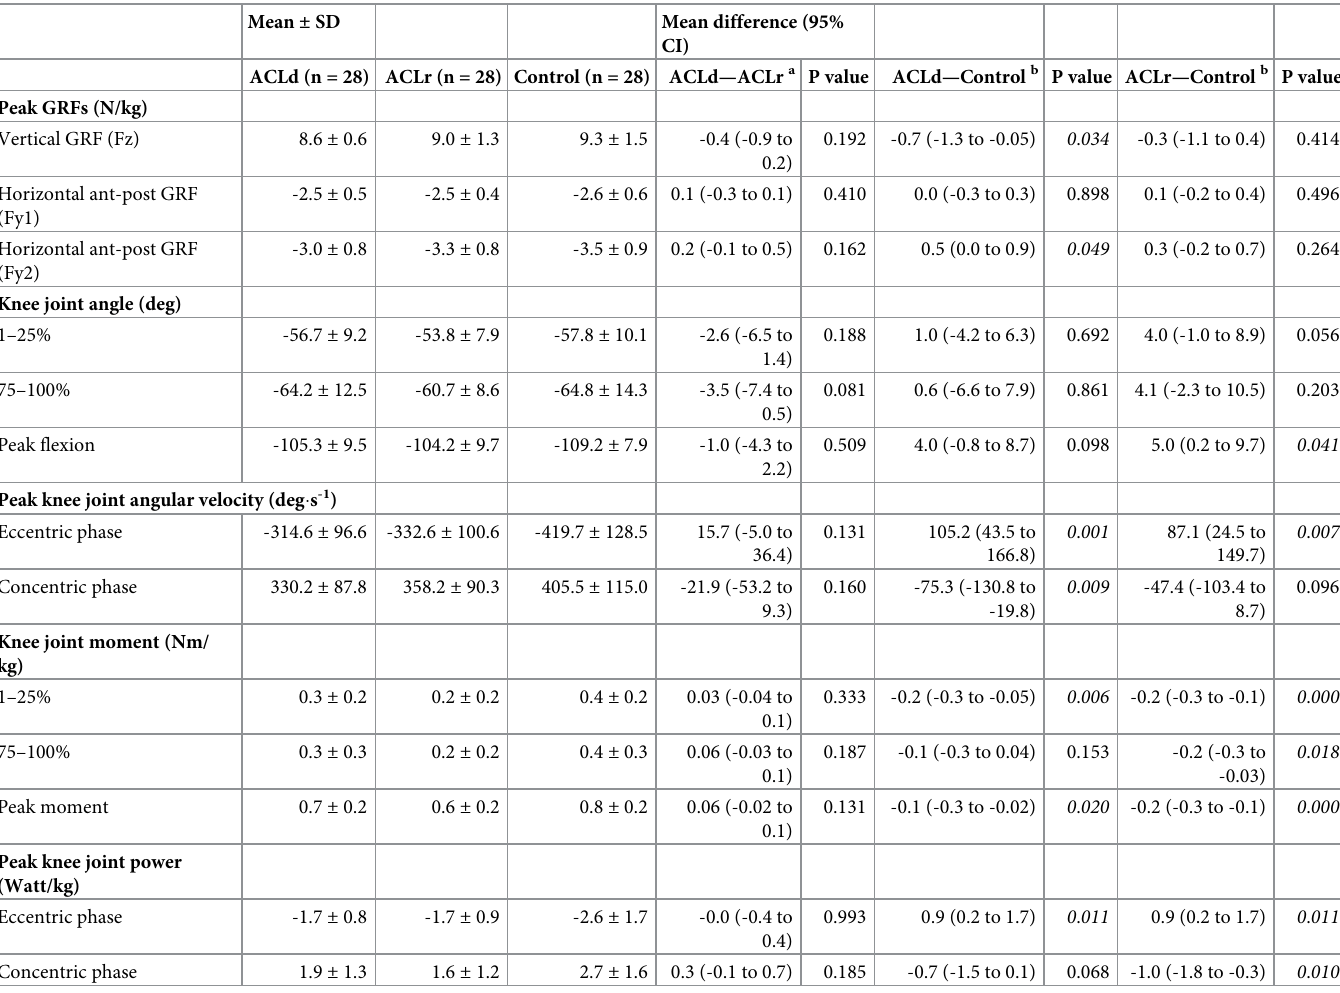
Table 2. Forward lunge